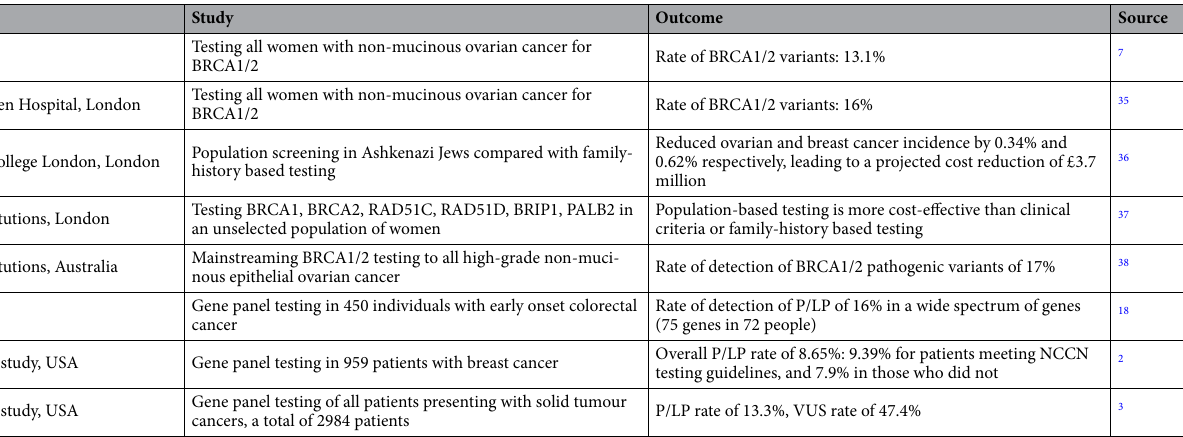
Table 1. Research studies undertaking genetic testing without the use of family-history based eligibility criteria.